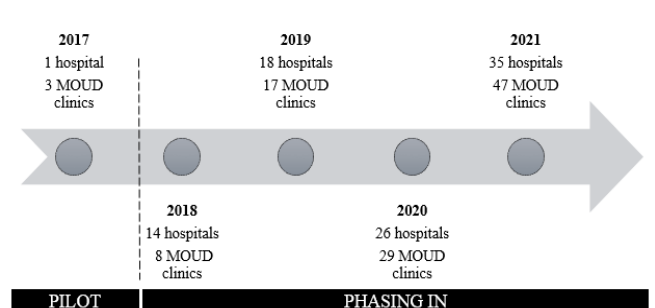
Figure 2. Timeline of implementation of the New York MATTERS* network.